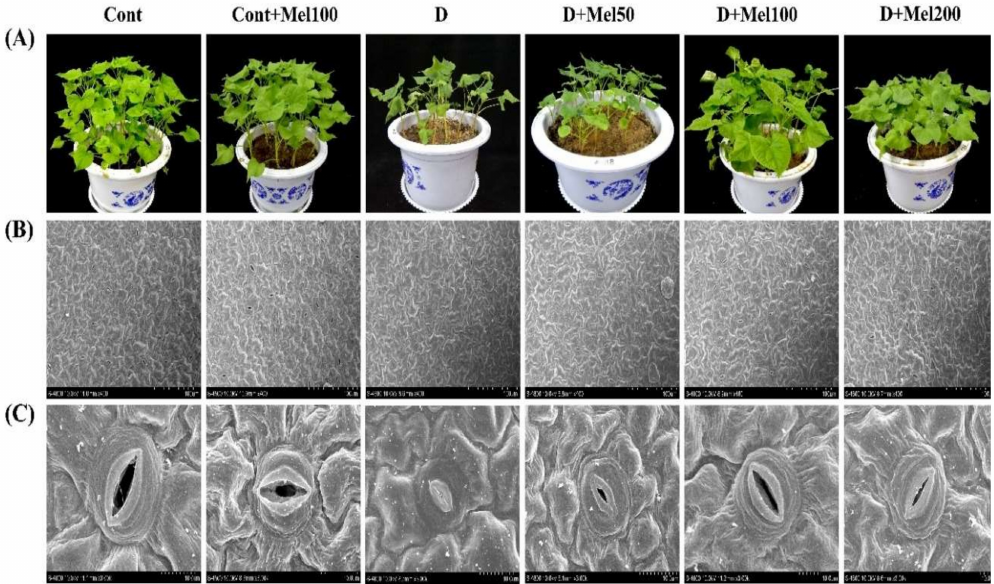
Figure 1. E ff ects of exogenous melatonin on phenotypic expression ( A ), stomatal properties of Tartary buckwheat leaves under drought stress ( B and C ) and magnification 400 × , scale bar = 100 µ m ( B ), and magnification 3000 × , scale bar = 10 µ m ( C ). Here, Cont: Control, 80% field capacity (FC); D: Drought, 20% FC; Mel50: 50 µ M melatonin; Mel100: 100 µ M melatonin, and Mel200: 200 µ M